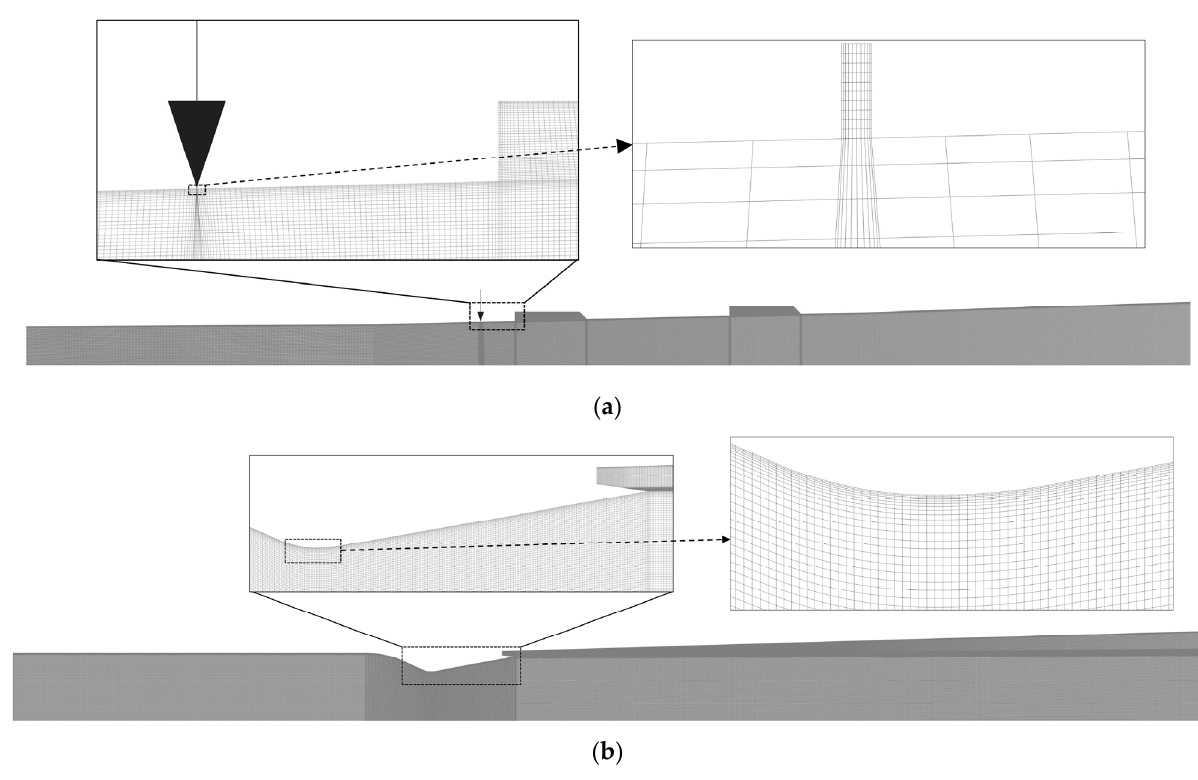
Figure 5. Local mesh of ( a ) the scramjet and ( b ) the DCR.